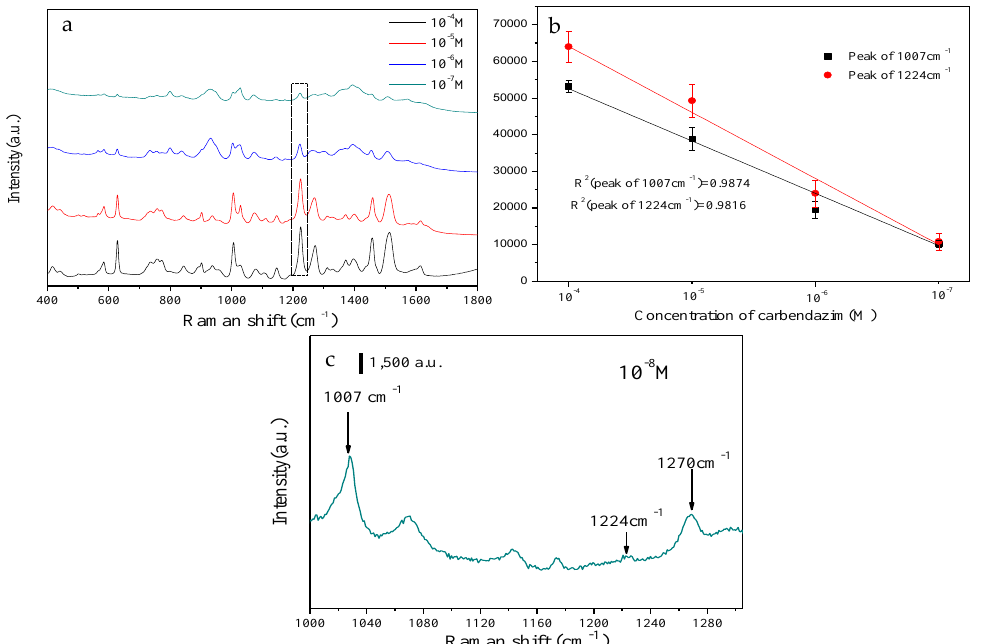
Figure 6. ( a ) SERS spectra of different concentrations of carbendazim. ( b ) Peaks at 1007 and 1224 cm − 1 on the SERS spectra shown in a. ( c ) SERS spectrum of 10 −8 M.